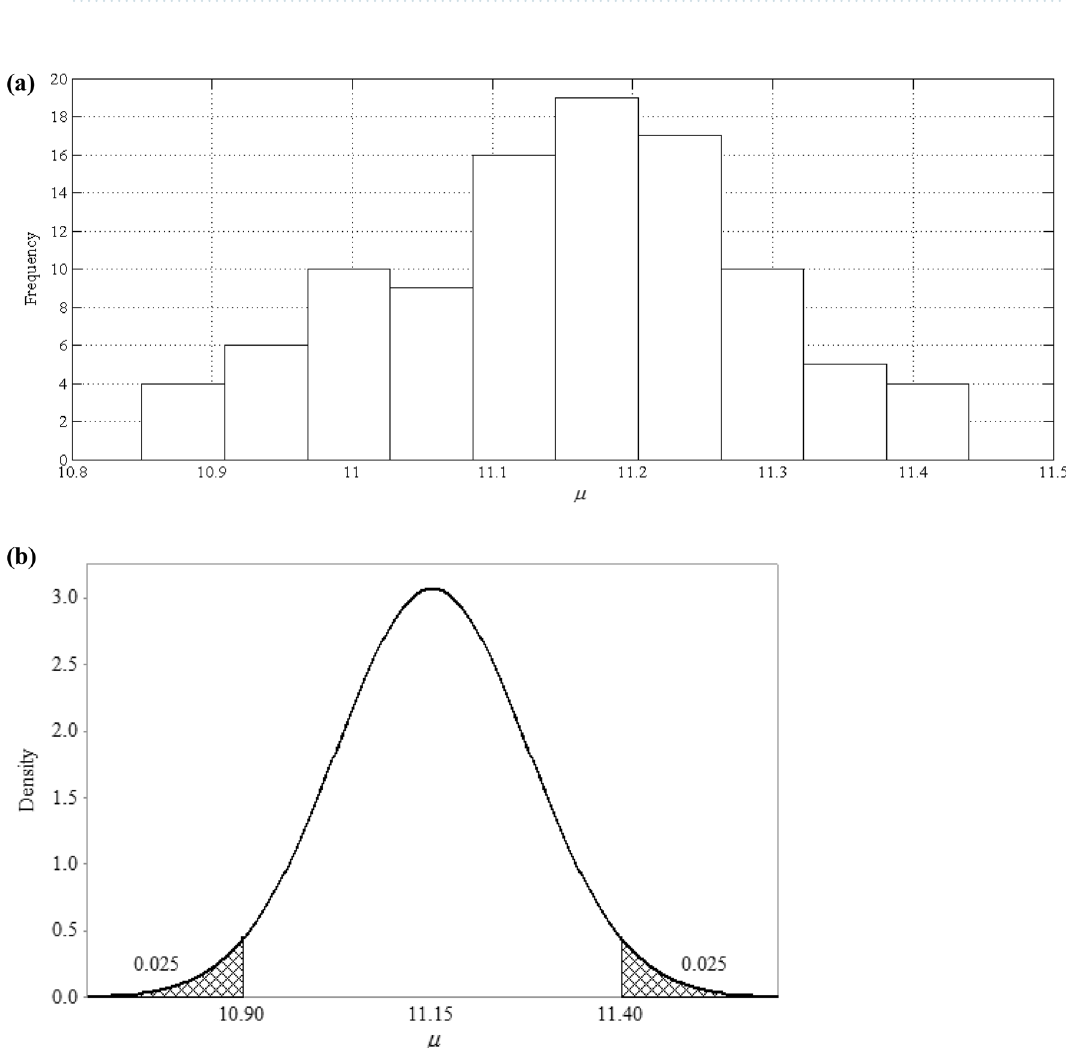
Figure 7. The uncertainty of the computed μ parameter for Seimareh sub-basin in spring under short-term future condition demonstrated by (a) a histogram and (b) a probability distribution